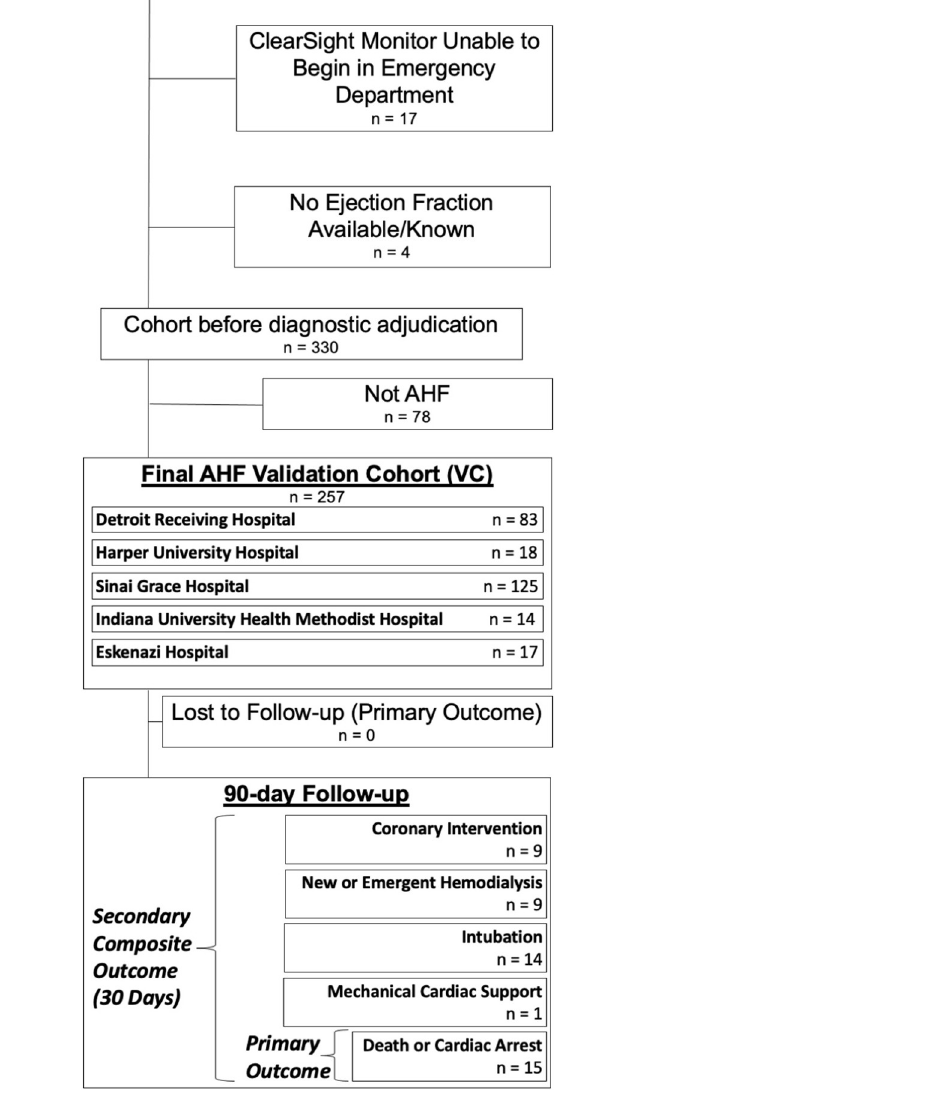
Fig 1. Validation cohort flow diagram. AHF = Acute Heart